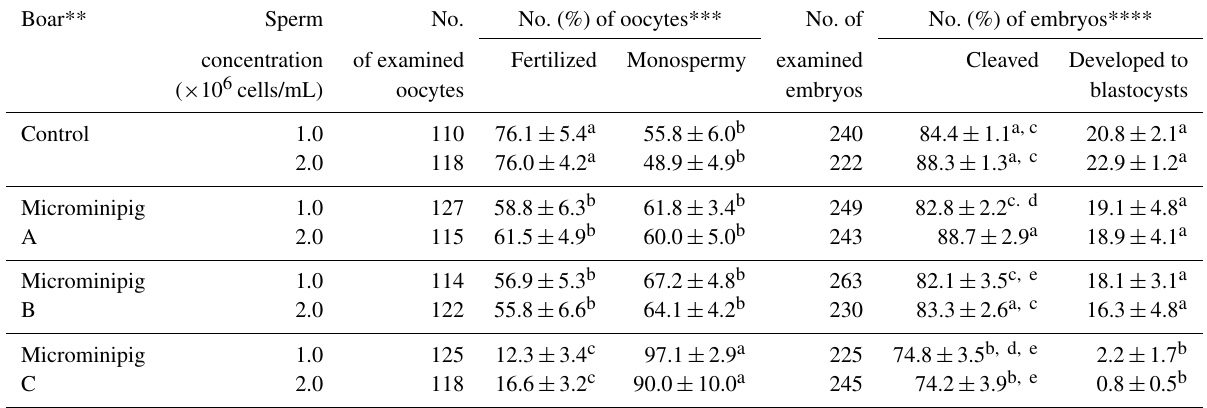
Microminipig 1.0 127 58.8 ± 6.3 b 19.1 ± 4.8 a A 2.0 115 61.5 ± 4.9 b 60.0 ± 5.0 b 18.9 ± 4.1 a Microminipig 1.0 114 56.9 ± 5.3 b B Microminipig 1.0 C 2.0 118 16.6 ± 3.2 c 90.0 ± 10.0 a 245 74.2 ± 3.9 b, e 0.8 ± 0.5